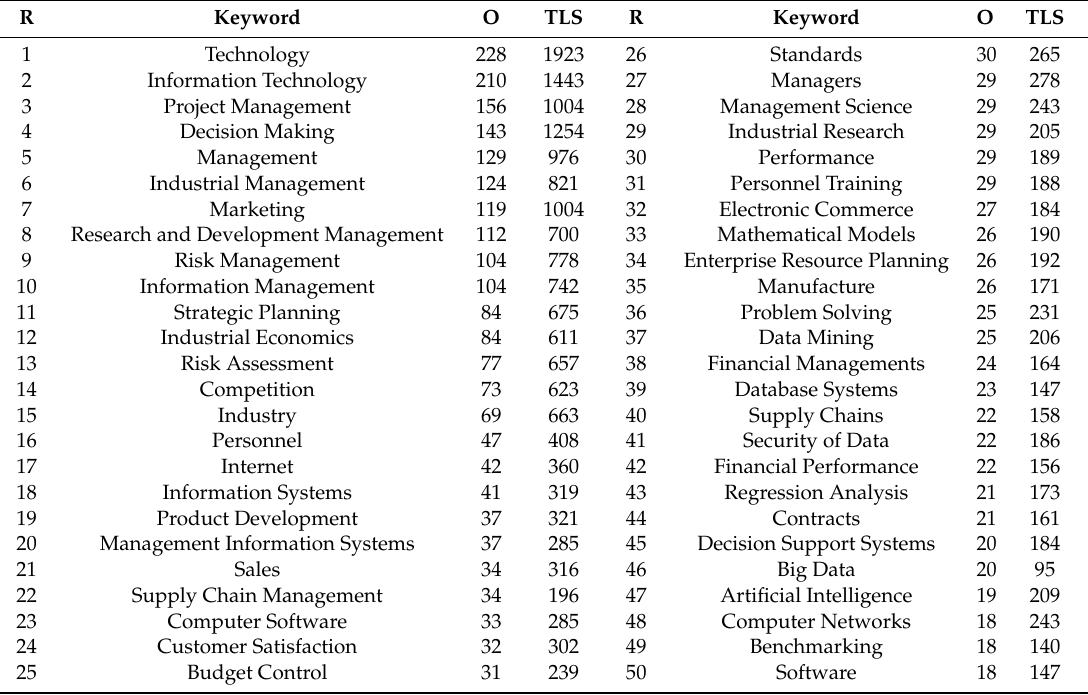
Table 5. Cluster 1. Top 50 keywords